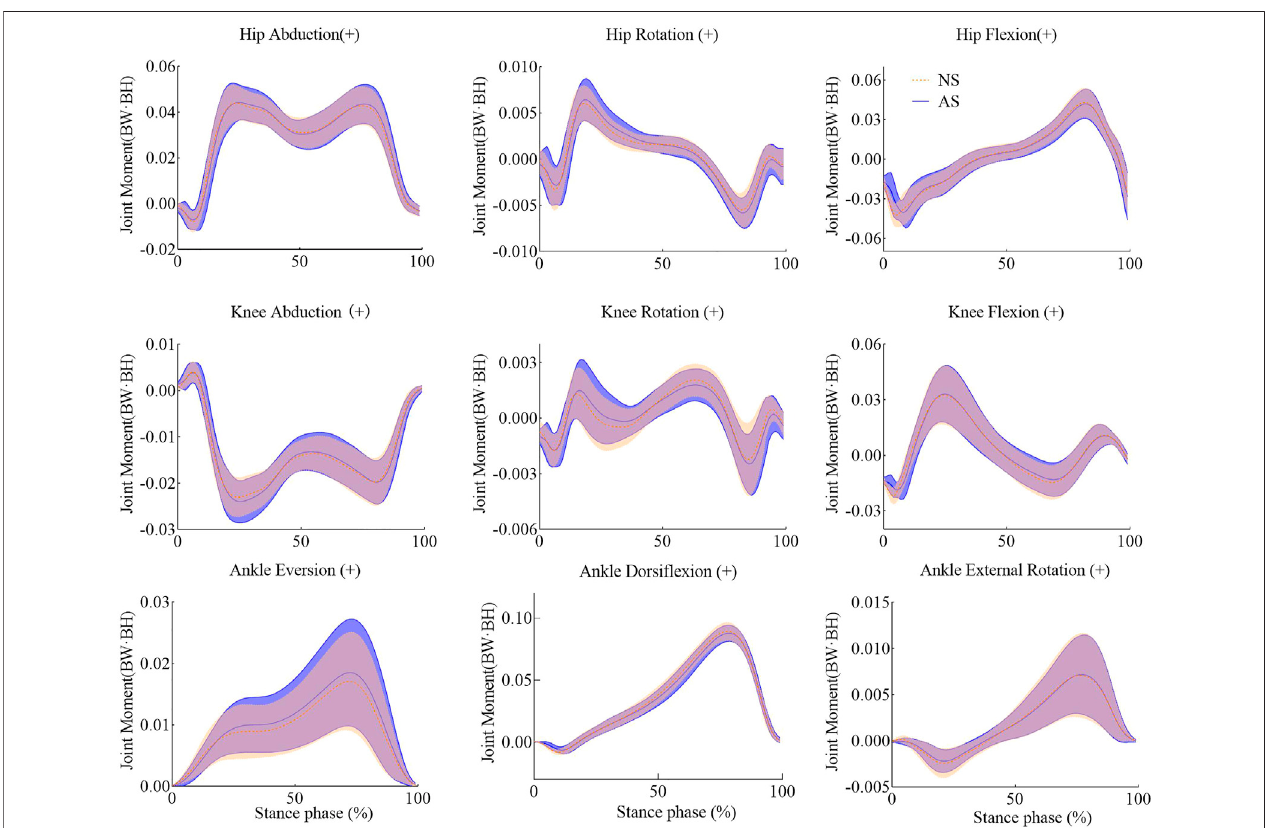
FIGURE 4 | Joint moments of lower extremities with shade ± 1 std for NS and AS during the stance phase.